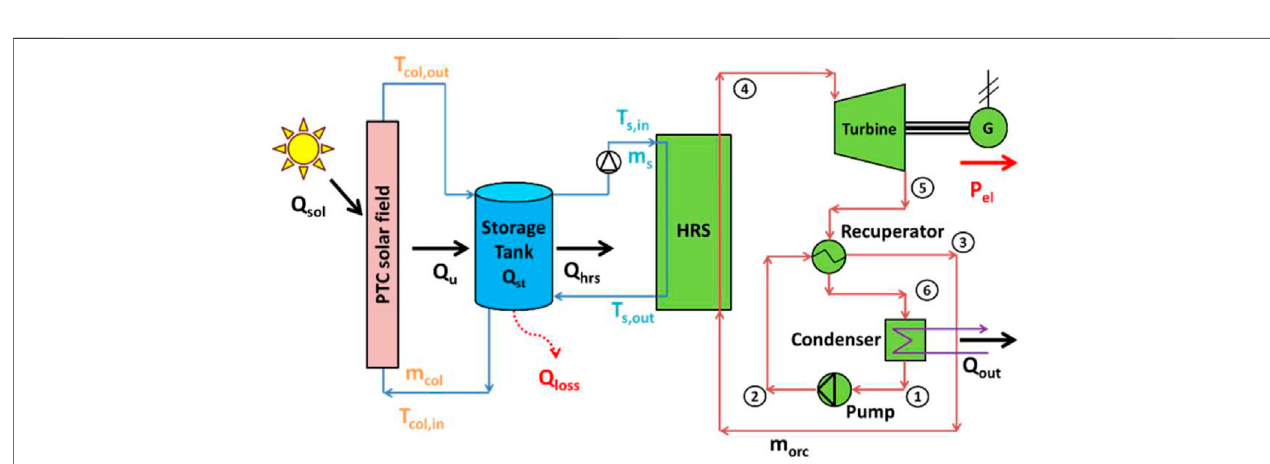
Frontiers in Energy Research |